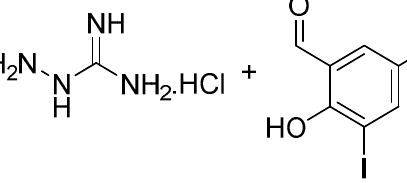
Figure 6. Reductive amination.